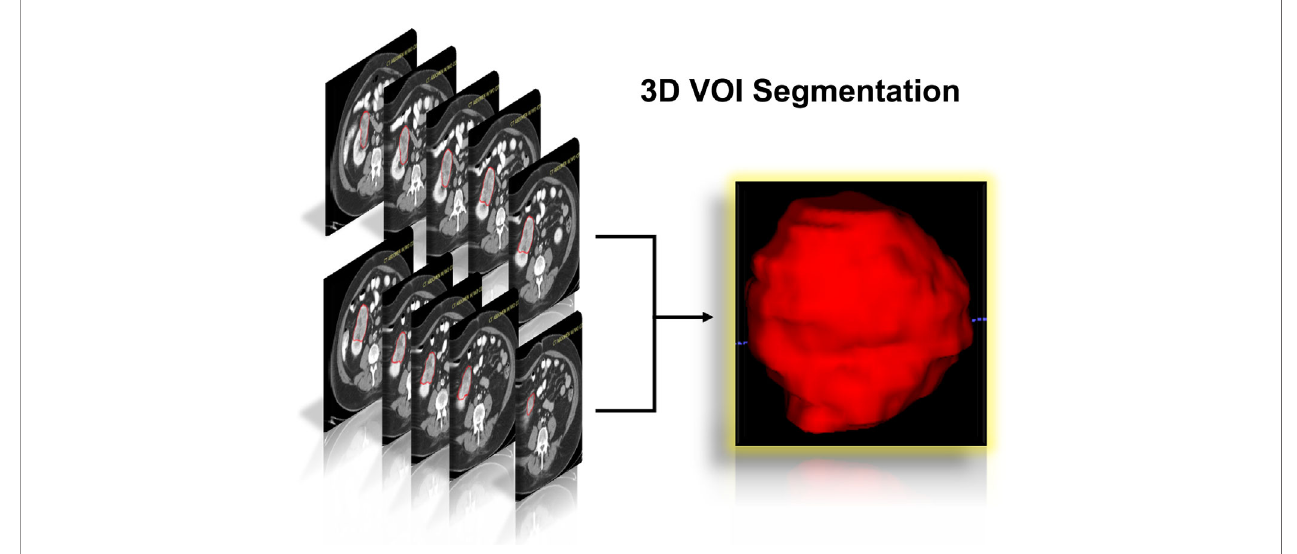
FIGURE 2 | Schematic diagram of the complete 3D geometric image obtained by manually drawing and segmenting the VOI from the CECT examination. 3D, three dimensions; VOI, volumes of interest; CECT, contrast-enhanced computed tomography